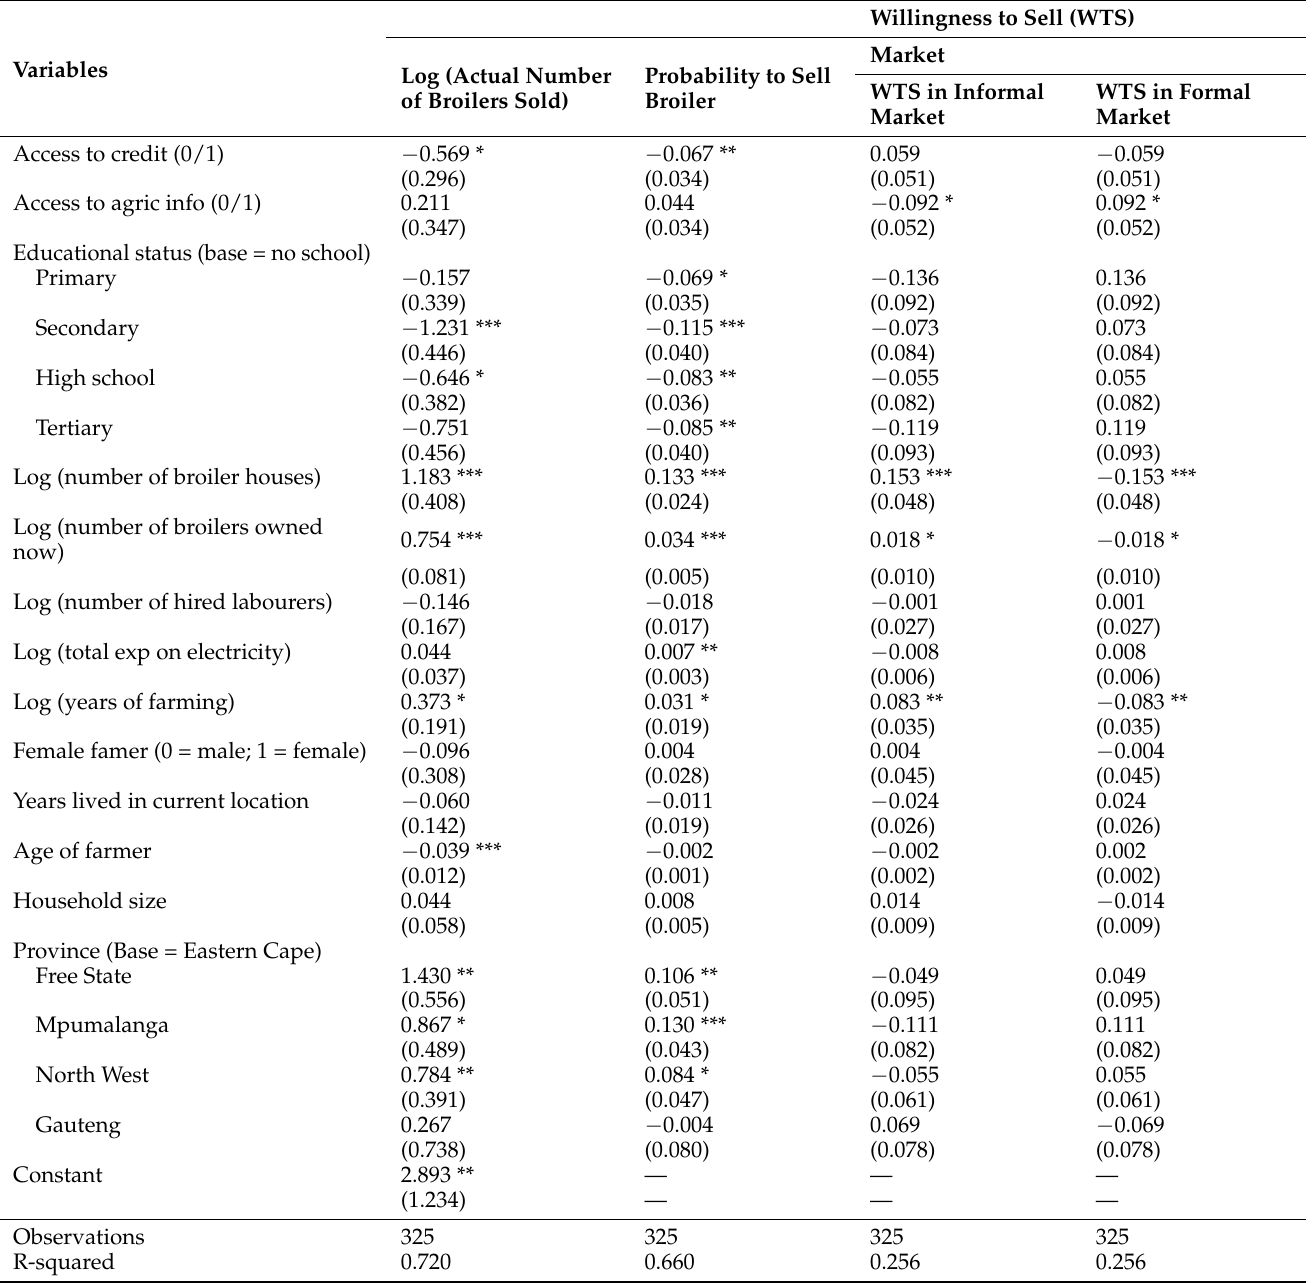
Table 5. Determinants of the number of broilers sold and propensity to sell per